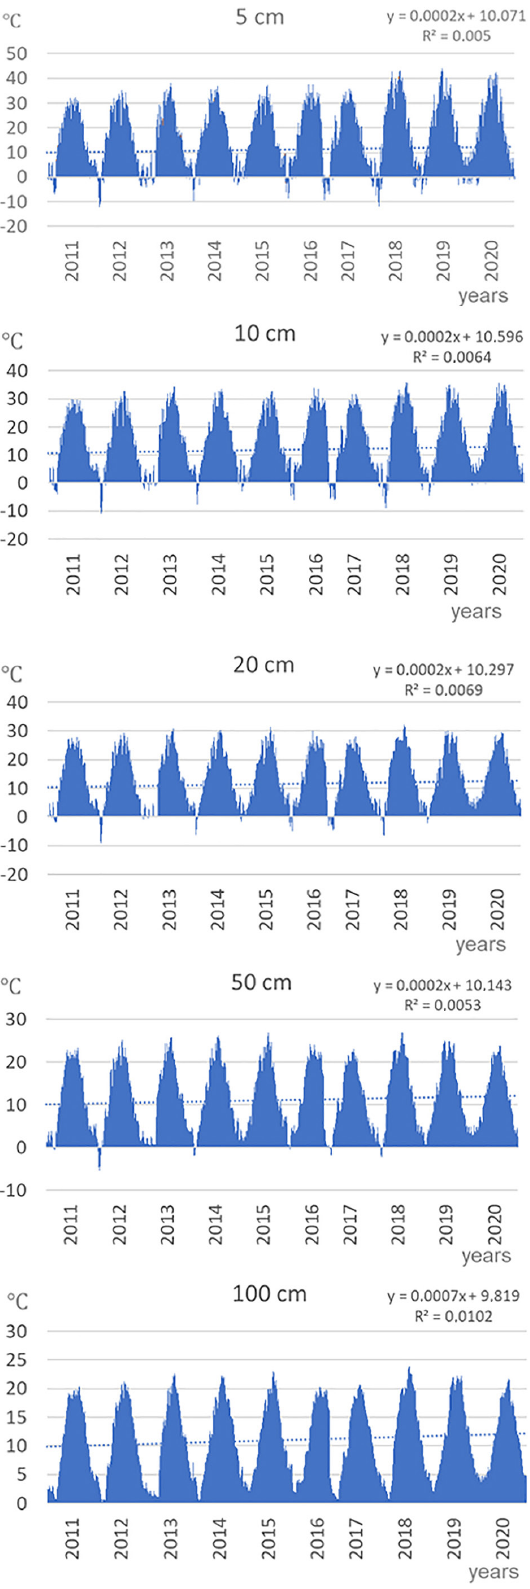
Fig. 3. The course of the temperature for individual soil levels in Poznań in the years 2011–2020 with the trend